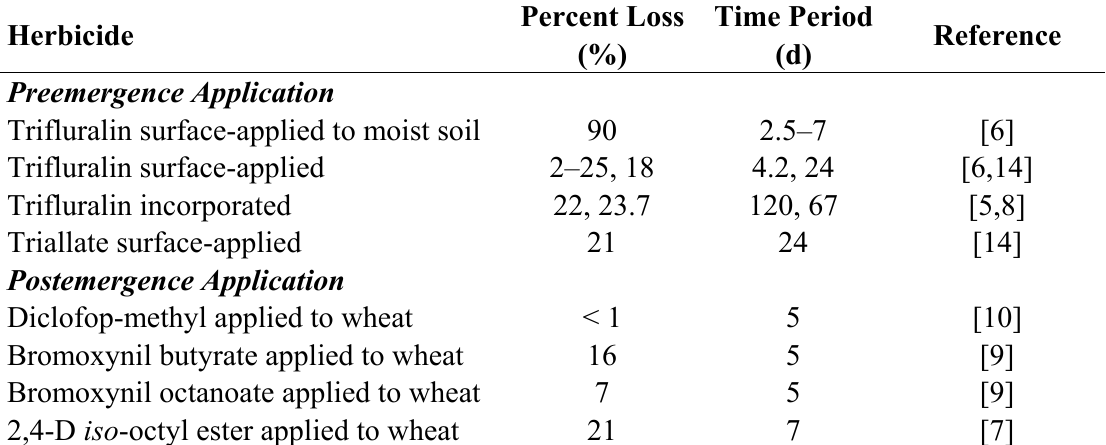
Table 1. Vapour losses of herbicides following pre- and postemergence field